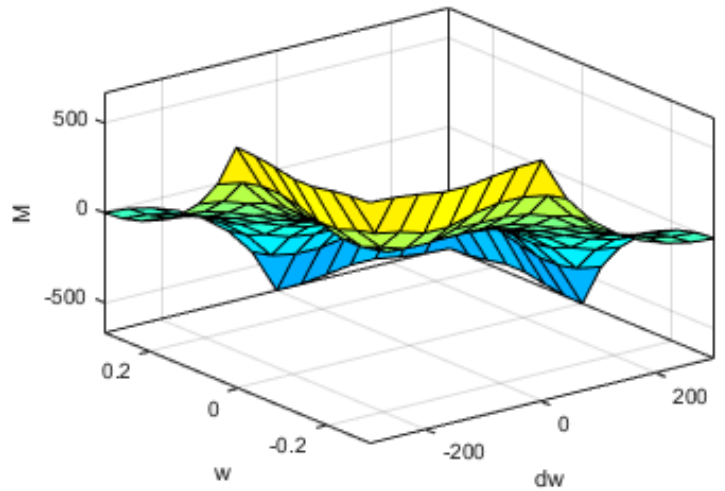
Figure 9. Surface M = f ( e θ , ω ).